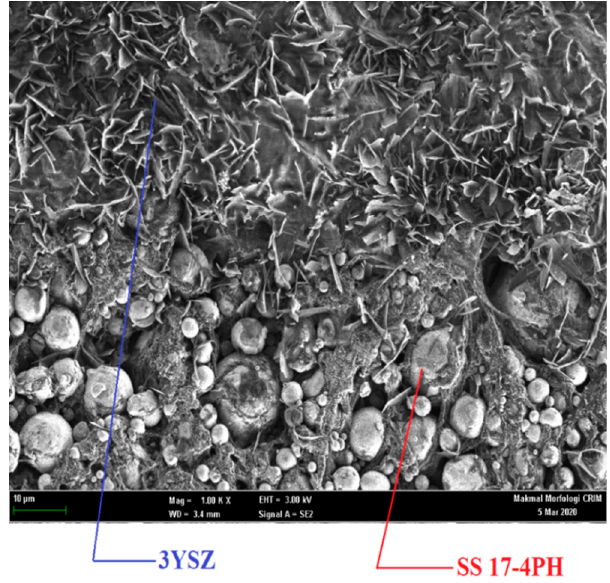
Figure 11. Bi-material micro-part of SS 17-4PH and 3YSZ materials.